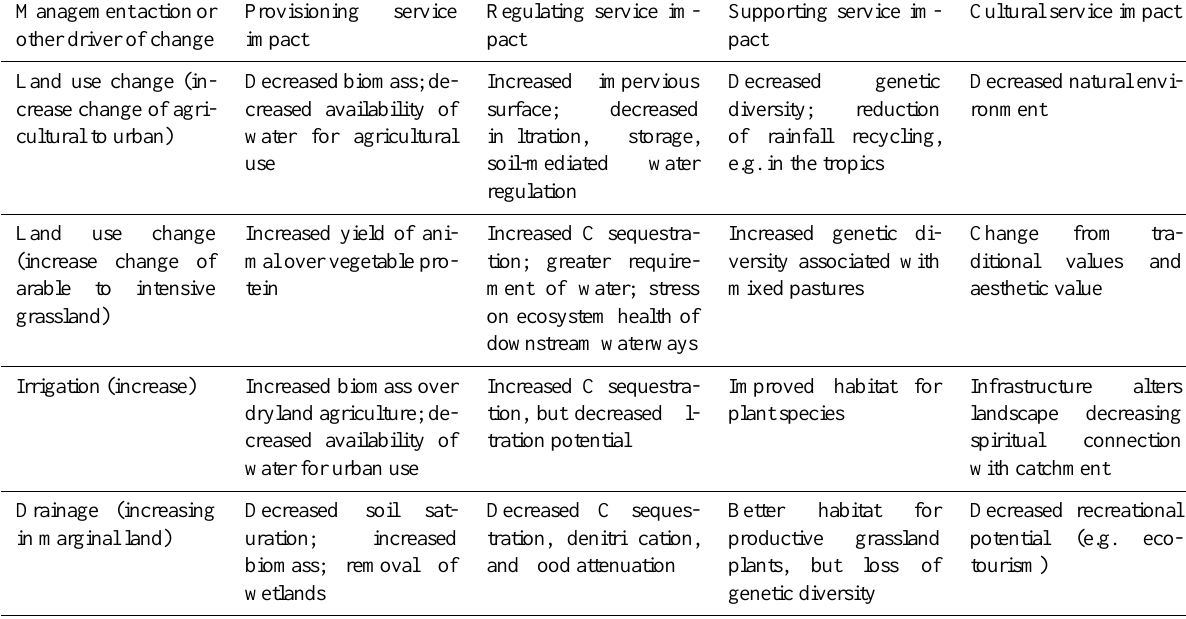
Table 4. Management actions affecting the soil water cycle and their impact on ecosystem